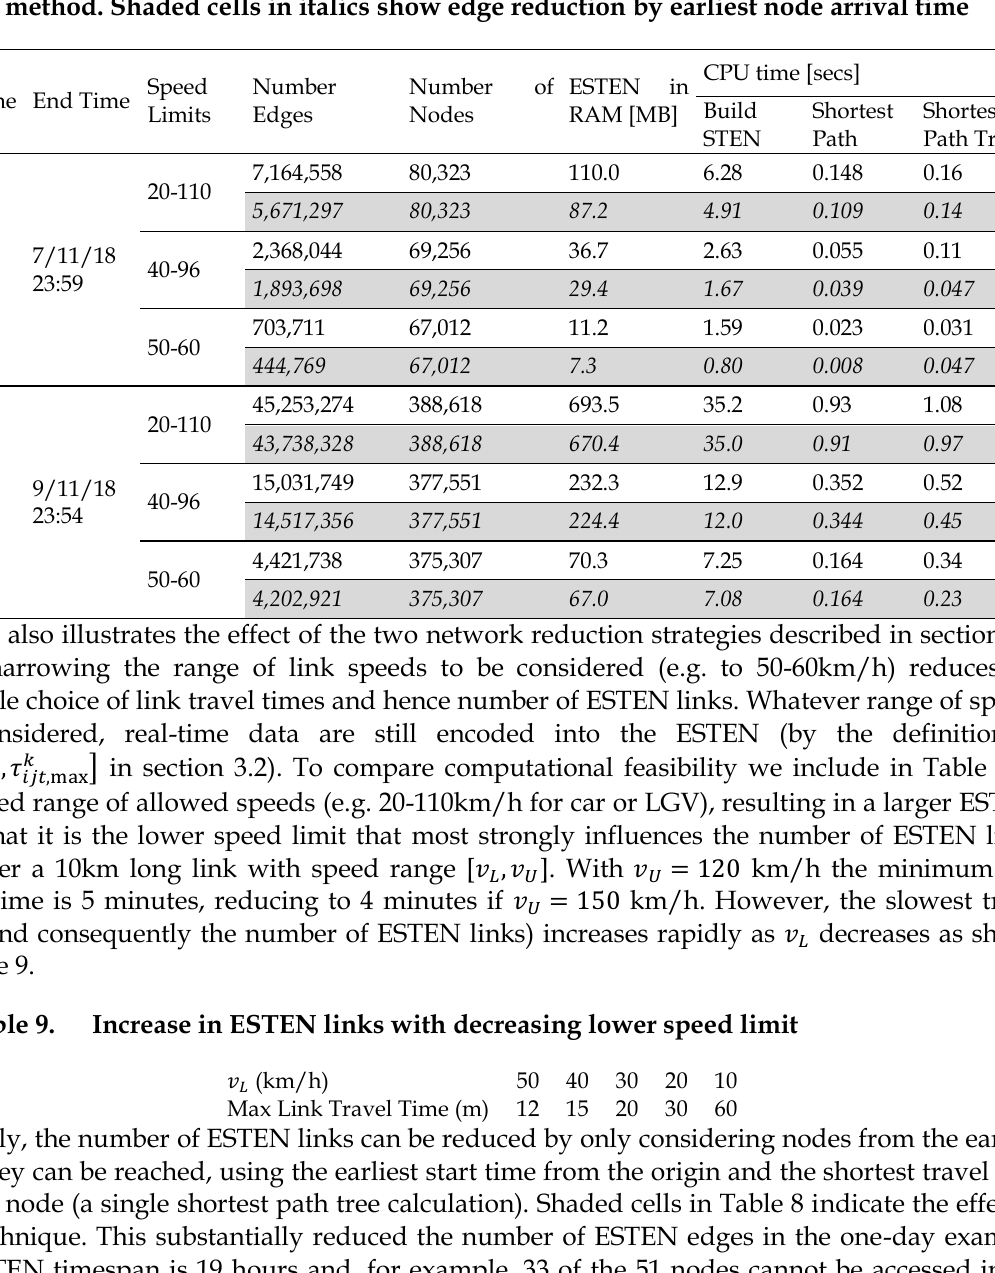
Increase in ESTEN links with decreasing lower speed limit 𝑣 𝐿